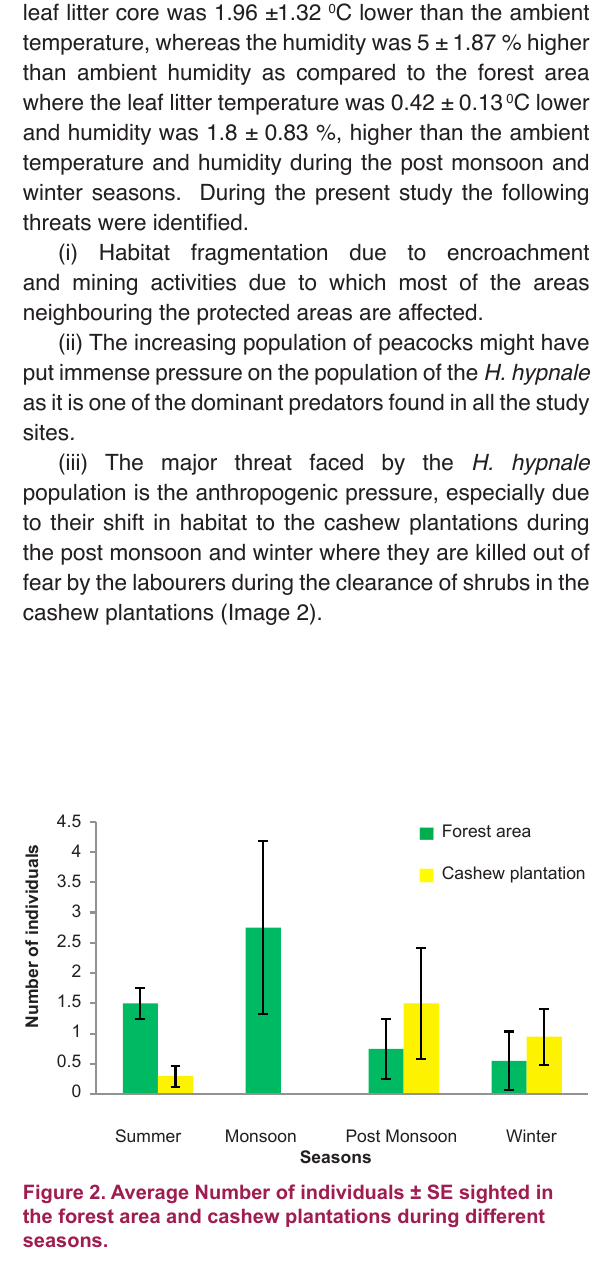
the cashew plantation during different seasons is given in Fig. 2. The Analysis of Variance (i.e. one-way ANOVA) for testing the abundance of H. hypnale for forest area with respect to different seasons showed that p = 0.254, df = 3, F =1.539, whereas, the one-way ANOVA to test the abundance of H. hypnale for the cashew plantation with respect to different seasons showed that p = 0.227, df = 3, F = 1.66. It was noted that the population which moved to the adjoining cashew plantations had low male: female ratio i.e. 0.227. It was also seen that most of the females that moved to the cashew plantations were gravid females. Thus, 65.9% of the total females sighted in the cashew plantations were gravid females. The temperature of the leaf litter core was 1.96 ±1.32 0 C lower than the ambient temperature, whereas the humidity was 5 ± 1.87 % higher than ambient humidity as compared to the forest area where the leaf litter temperature was 0.42 ± 0.13 0 C lower and humidity was 1.8 ± 0.83 %, higher than the ambient temperature and humidity during the post monsoon and winter seasons. During the present study the following threats were identified.